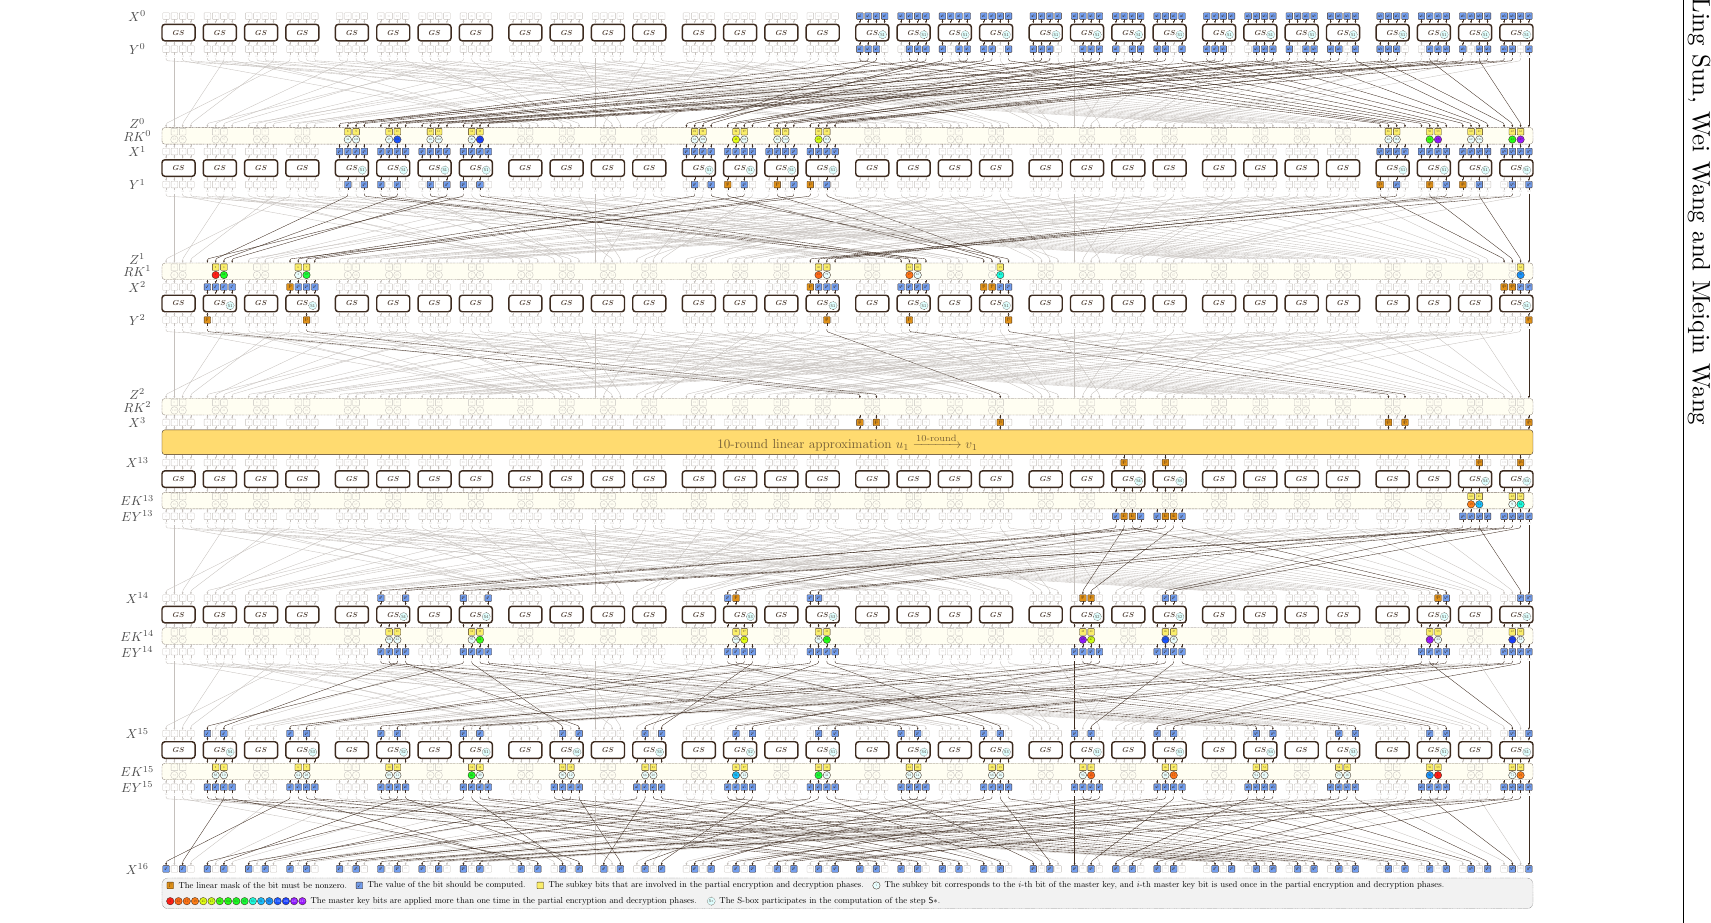
Figure 7: Key-recovery attack on 16-round GIFT-128 in GIFT-COFB